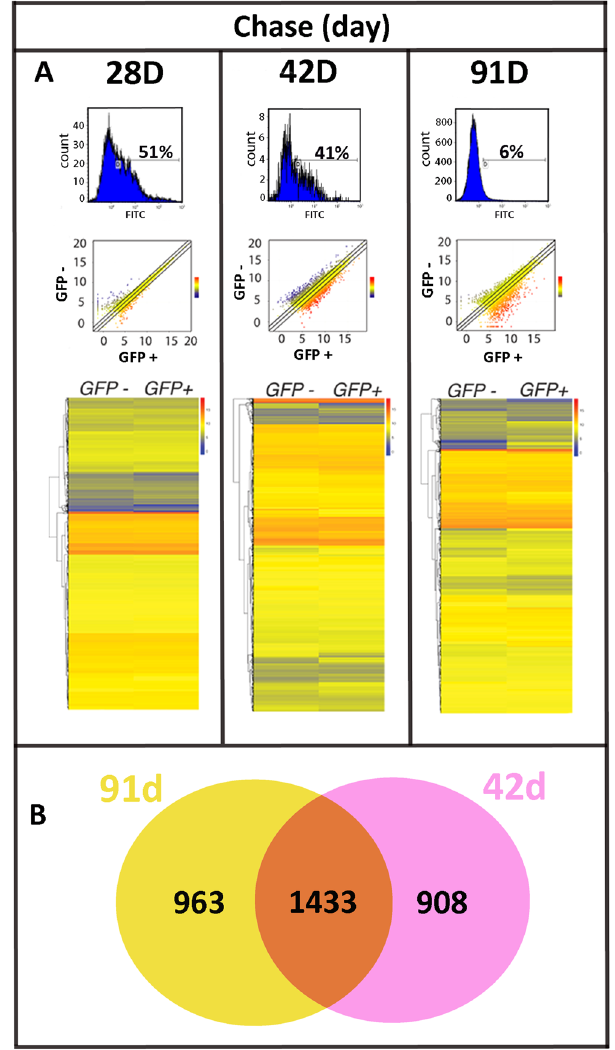
Figure 2. Differential gene expression between GFP − and GFP + corneal cells are greater at 42 d post chase and thereafter. ( A ) FACS analysis of freshly dissociated K5tTA X TRE-H2BGFP corneal epithelial cells demonstrated decreased GFP + LRC percentages as the chase period was extended from 28 d (51%, n = 5) to 42 d (41%, n = 3) and to 91 d (6%, n = 5). The scatterplot of the RNA-Seq expression data shows the differences in gene expression between GFP + (x-axis) and GFP − (y-axis) in log2-transformed scale from 28 d, 42 d and 91 d chase. Gene expression change between GFP − and GFP + is represented as a color (blue, low expression to red, high expression). Differential gene expression increases at 42 d and 91 d chase. The heat map includes 12,597 genes for each chase period. Color differences between GFP − and GFP + become more apparent at 42 d chase onwards. ( B ) Venn diagram of significantly differentially expressed genes between GFP − and GFP + shows there are 1433 genes (orange) shared between 42 d and 91 d chase. There are 908 genes (pink) exclusively differentially expressed at 42 d and 963 genes (yellow) exclusively differentially expressed at 91 d